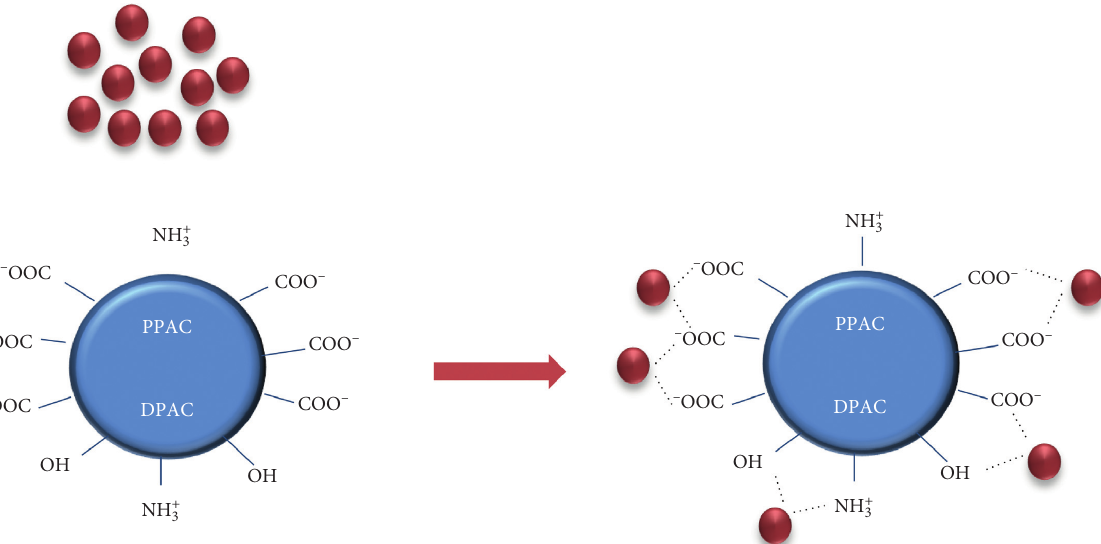
Figure 14: Schematic diagram illustrating the proposed mechanisms for heavy metals’ adsorption onto DPAC and